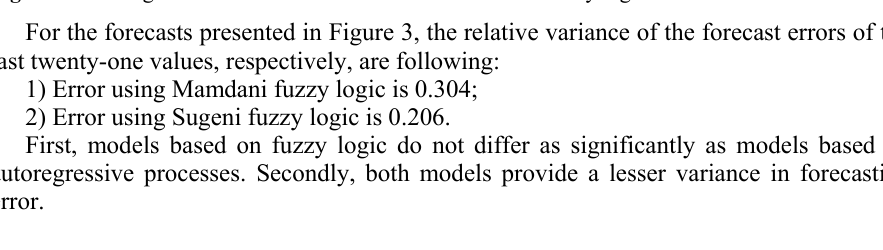
Fig. 3 Forecasting the number of taxi service orders based on fuzzy